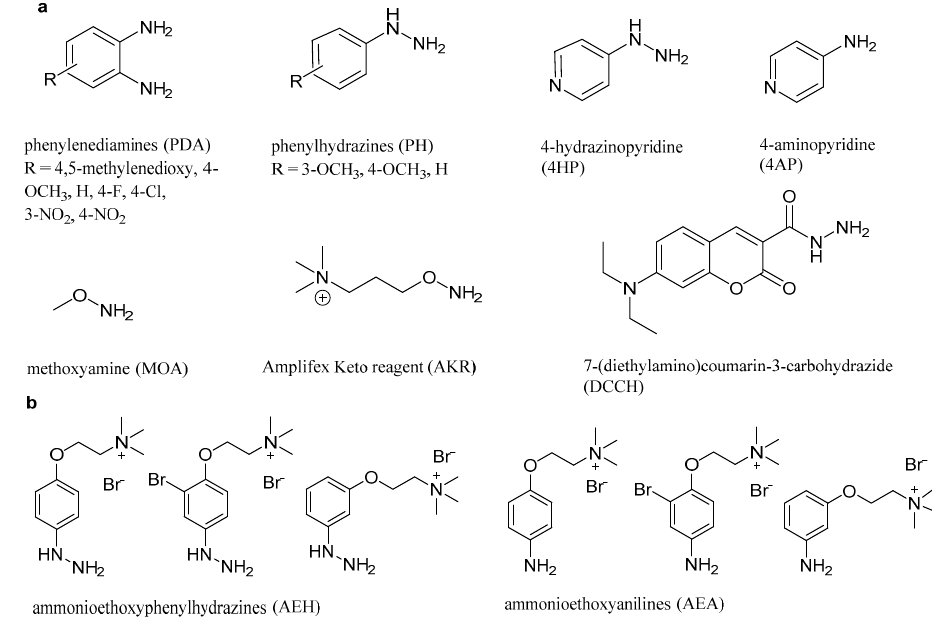
Figure 2. Chemical structure of the reagents tested for derivatization of methylglyoxal with subsequent ESI-MS detection: ( a ) commercially available compounds; ( b ) synthesized reagents for derivatization of carbonyl compounds, from left to right, 2-(4-hydrazineylphenoxy)- N , N , N -trimethylethan-1-aminium bromide (4-AEH), 2-(2-bromo-4-hydrazineylphenoxy)- N , N , N -trimethylethan-1-aminium bromide (3-BrAEH), 2-(3-hydrazineylphenoxy)- N , N , N -trimethylethan-1-aminium bromide (3-AEH), and the corresponding anilines including 2-(4-aminophenoxy)- N , N , N -trimethylethan-1-aminium bromide (4-AEA) according to Eggink et al.